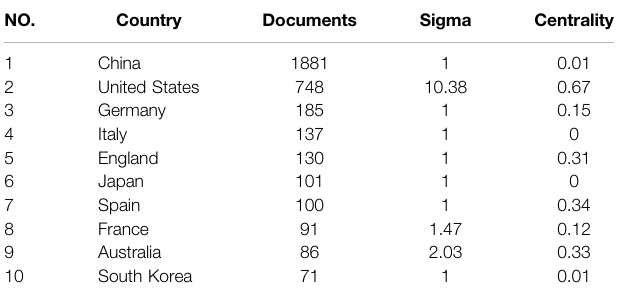
TABLE 1 | More details about the most productive 10 countries/regions with documents on SMAD7 in the fi eld of oncology. NO.